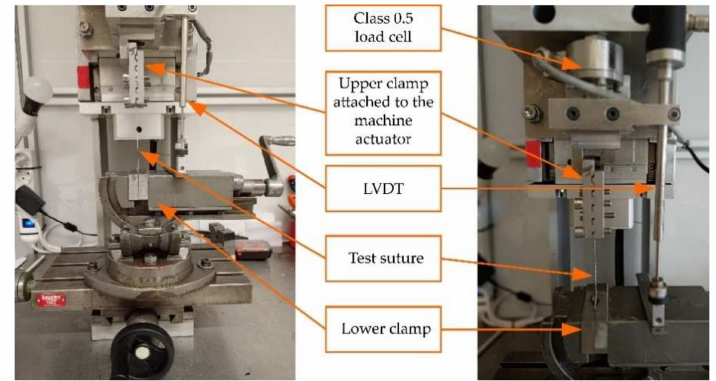
Figure 1. Uniaxial traction/compression testing